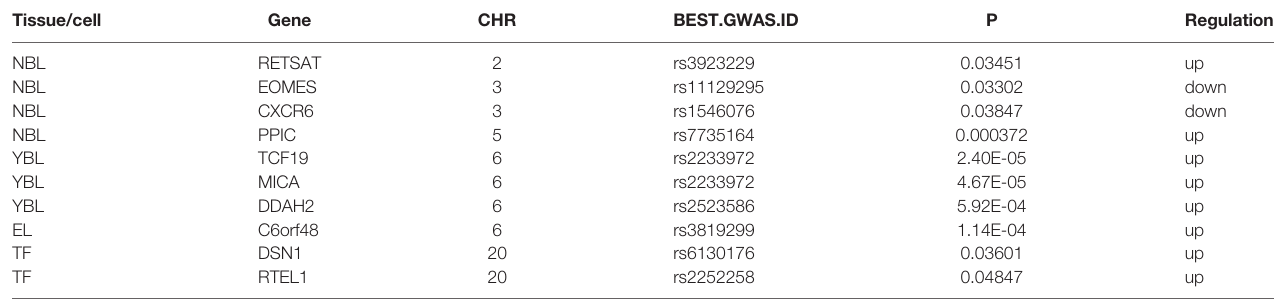
TABLE 3 | The common genes identi fi ed by both TWAS and microarray expression data. Tissue/cell Gene CHR